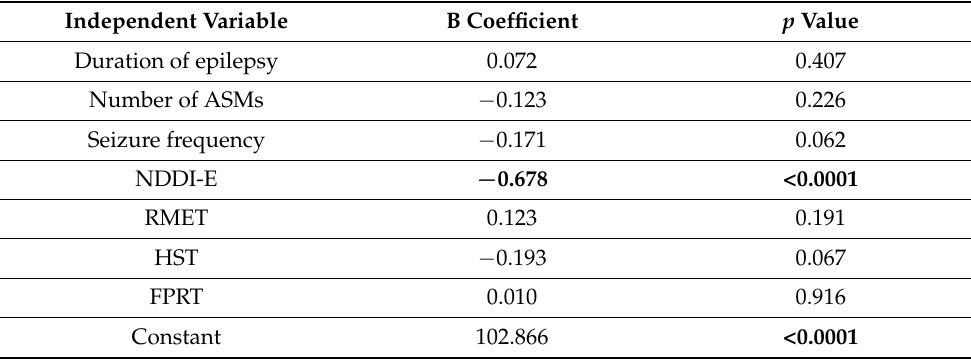
Table 4. A multiple regression model with QOLIE-31 total score as the dependent variable (F(7,68) = 14.180, p < 0.0001, Adjusted R 2 = 0.552, missing n = 5 (6.2%)). Variables with p < 0.05 are bold. Independent Variable B Coefficient p Value Duration of epilepsy 0.072 0.407 Number of ASMs − 0.123 0.226 −